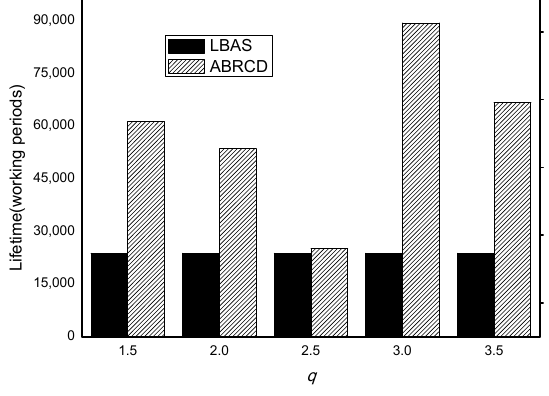
Figure 25. Lifetime with different q.